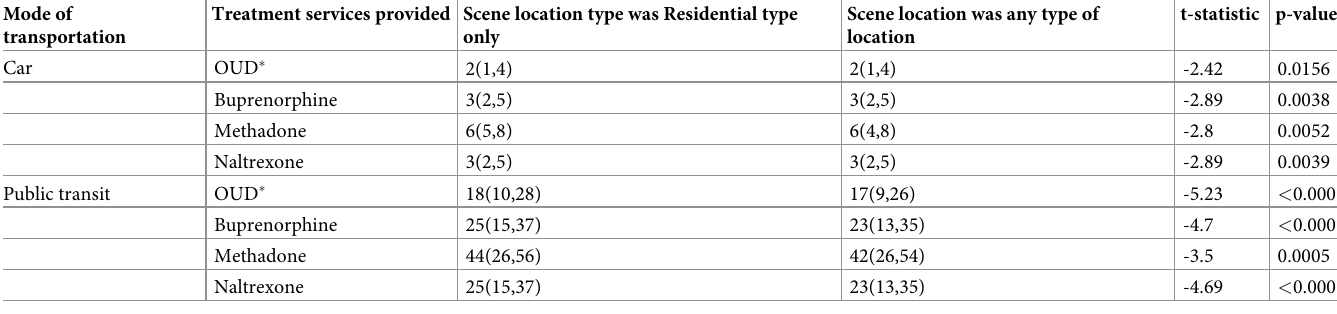
Table 3. Median travel time and interquartile range (25 th and 75 th quantile values) based on restricting scene location type of EMS run to Residential type only vs. any location type. Mode of